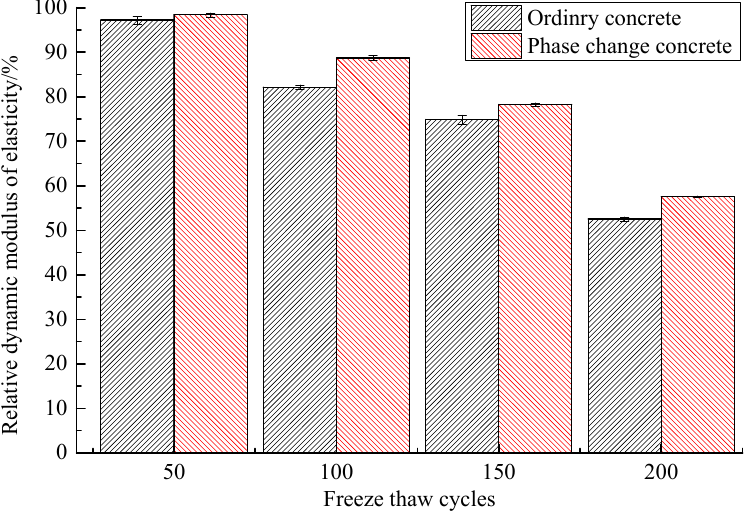
Figure 7. Change of mass loss rate of concrete during freeze–thaw cycles.